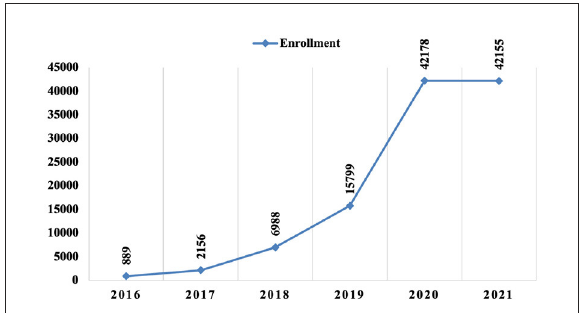
FIGURE3 Trends in enrollment in courses in the learning pathway “Syphilis and other STIs” (2016–2021).